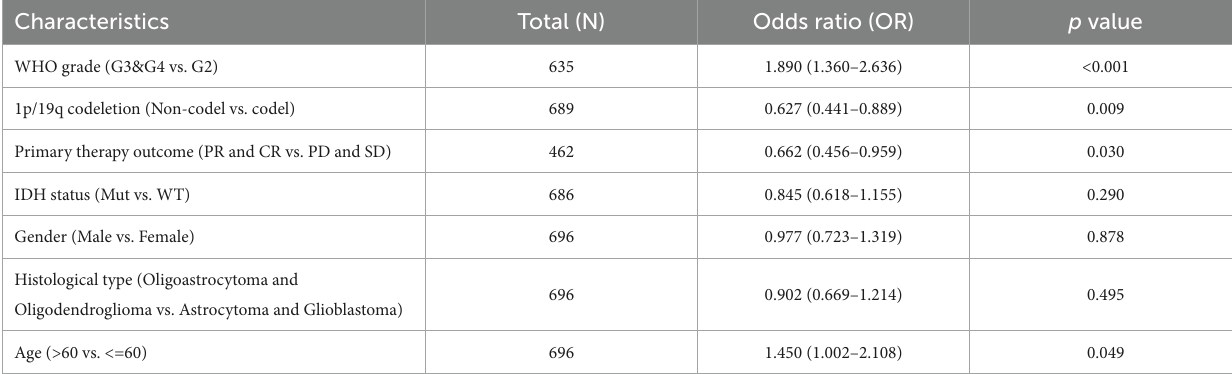
TABLE 2 Multivariate logistic regression of TMEM131L expression on prognosis of overall survival in GCB and LGG. Characteristics